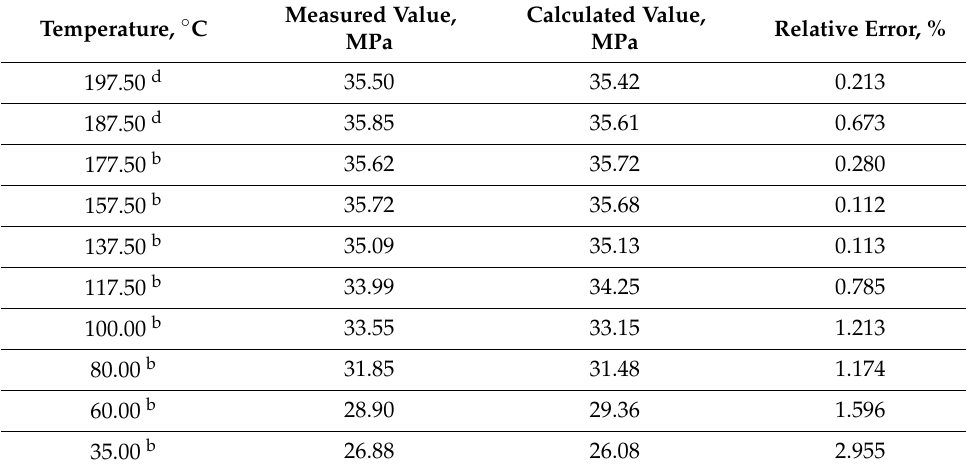
Table 7. Comparison of experimental and simulation results of bubble/dew point pressure at different temperatures.